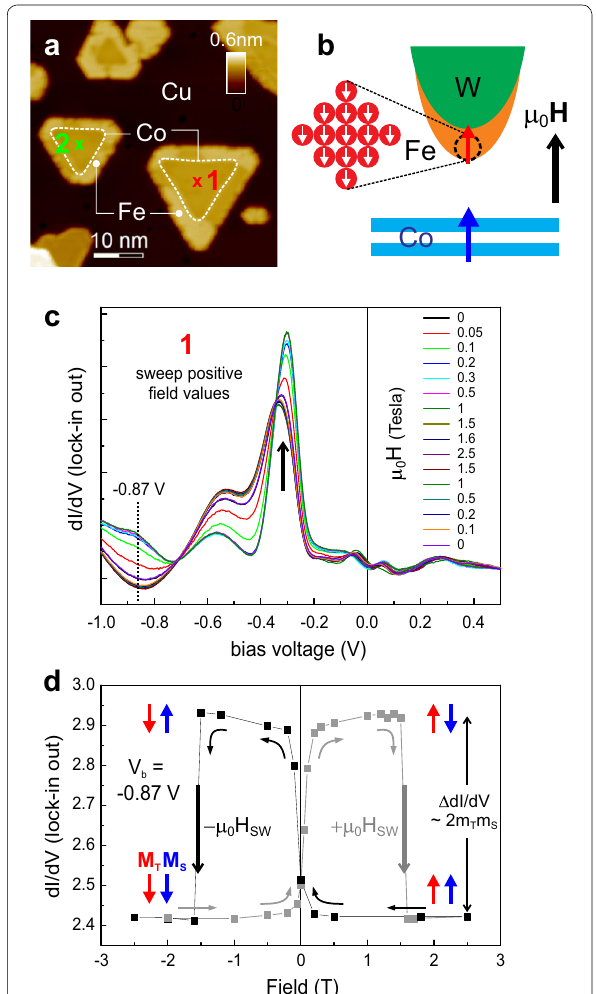
Fig. 3 Magnetic hysteresis of d I /d V in spin‑polarized STM/S. a STM image of two triangular Co cores of Fe‑decorated Co islands on which the magnetic‑field‑dependent d I /d V were measured. The inset shows the apparent STM height profile along the white solid line. 0.2 V; I set 1 nA). b A schematic of spin‑STM measurement ( V b = − = on a bilayer Co island in an external magnetic field μ 0 H . c A set of d I / d V curves measured under a varying μ 0 H ext at the position “1” marked in a. ( V stab 0.5 V; I stab 1 nA). d Magnetic hysteresis extracted from = = the field dependence of d I /d V values at V b 0.85 V ( c ) (Reprinted = − from [19] with permission from American Institute of Physics (Copy‑ right